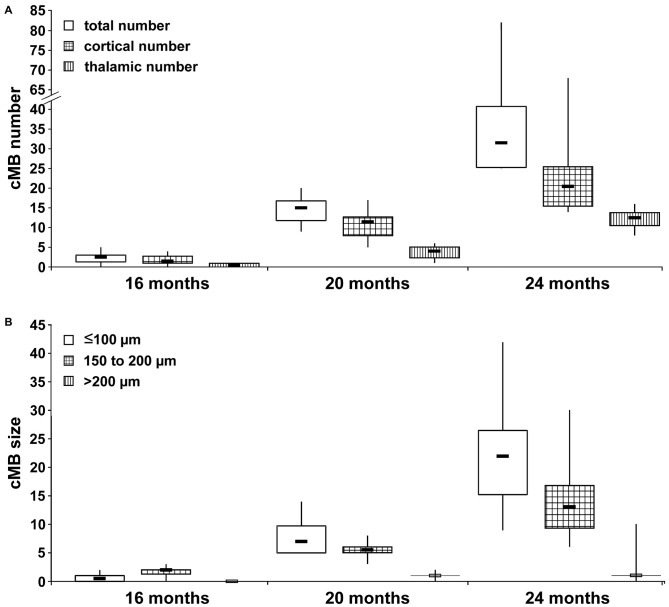
Spatial and size distribution of cerebral microbleeds (cMBs) depending on age. (A) Total cMB numbers and the amount of cMBs located in cortex and thalamus were obtained for APP23-tg mice aged 8, 12, 16, 20 and 24 months. Since APP-tg mice aged 8 and 12 months did not display cMBs only values for APP-tg mice aged 16, 20 and 24 months (each group n = 6) are shown. (B) cMBs were graded depending on size (≤100 μm, 100–150 μm and >200 μm) for APP-tg mice aged 16, 20 and 24 months (each group n = 6).